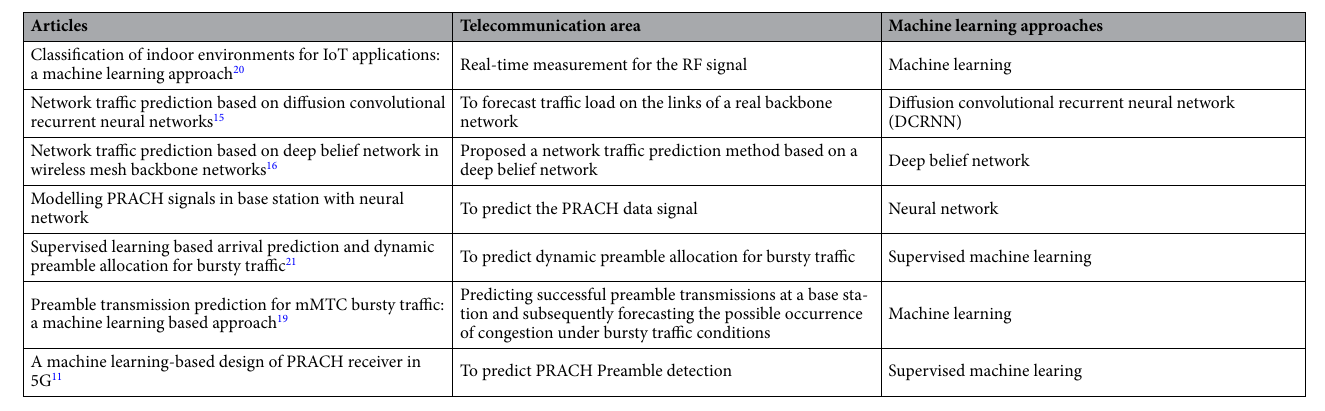
Table 1. Implementation of Machine learning in the domain of